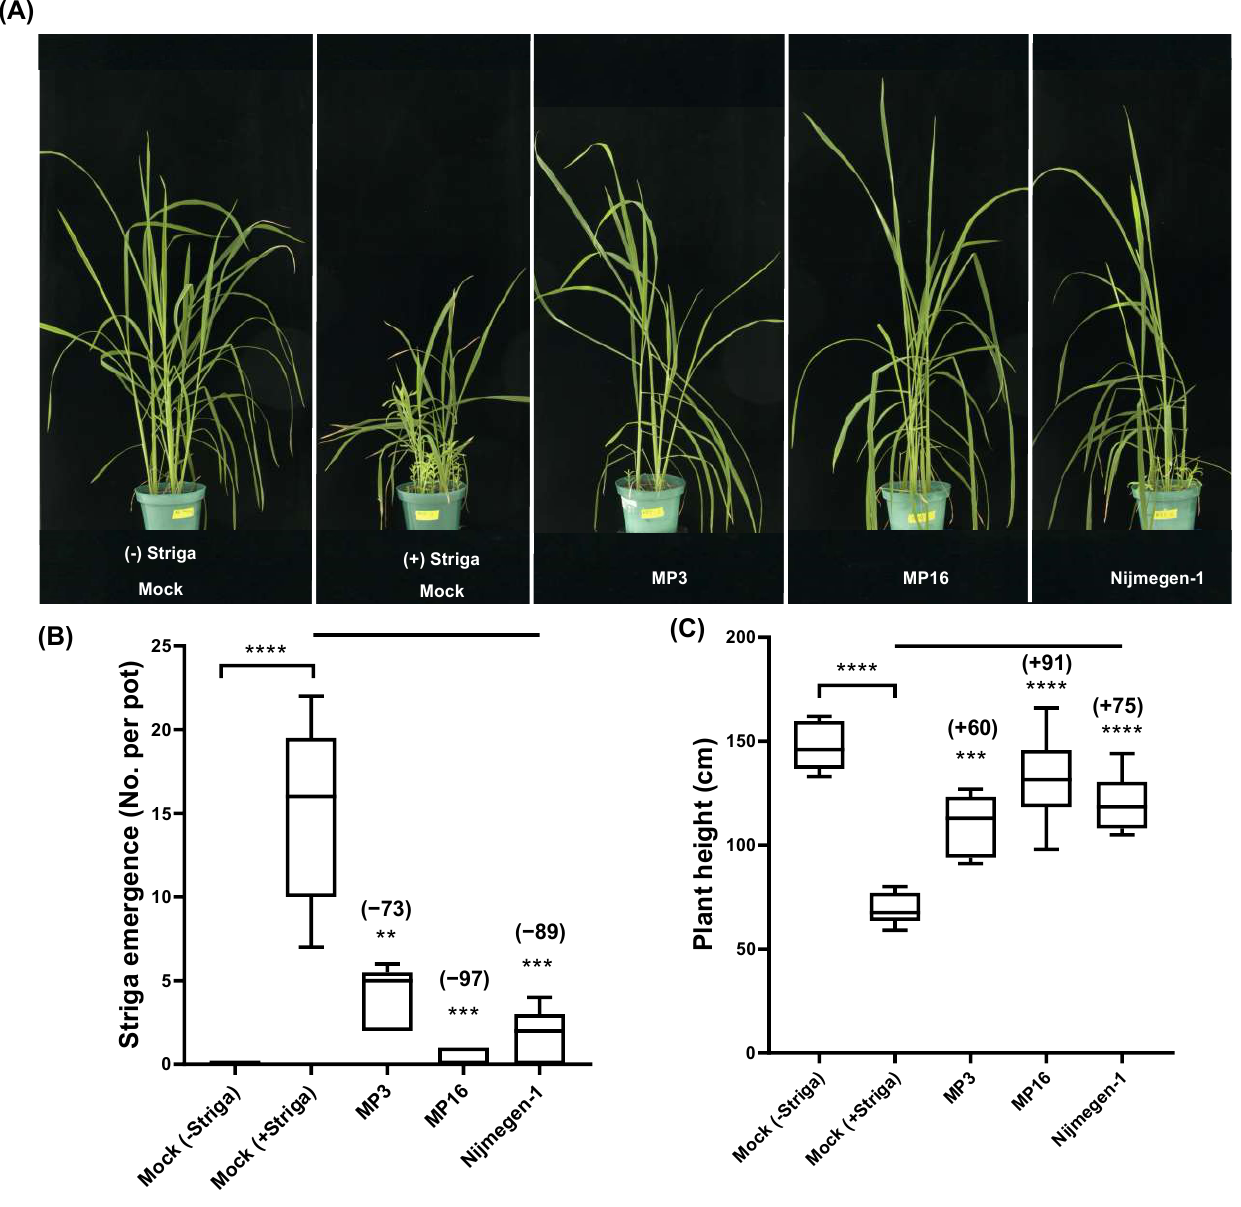
Figure 3. Striga emergence in response to the application of various SL analogs in pots under greenhouse conditions. ( A ) Representative pots of greenhouse study, showing Striga emergence under different treatments. ( B ) Number of Striga plants that emerged in mock, MP3, MP16, or Nijmegen-1 treatment. The selected SL analogs were applied twice at a 1 µ M concentration to 10-day preconditioned Striga -infested pots. ( C ) Rice plant height in response to different treatments. Data are means ± SE ( n = 6). Error bars represent the standard error of the mean. Values in parenthesis show the percentage increase (+) or decrease (−) over mock treatment. For each SL analog, treatments with various asterisks differ significantly according to one-way analysis of variance (ANOVA), ** p < 0.005, *** p < 0.005, **** p < 0.0005).